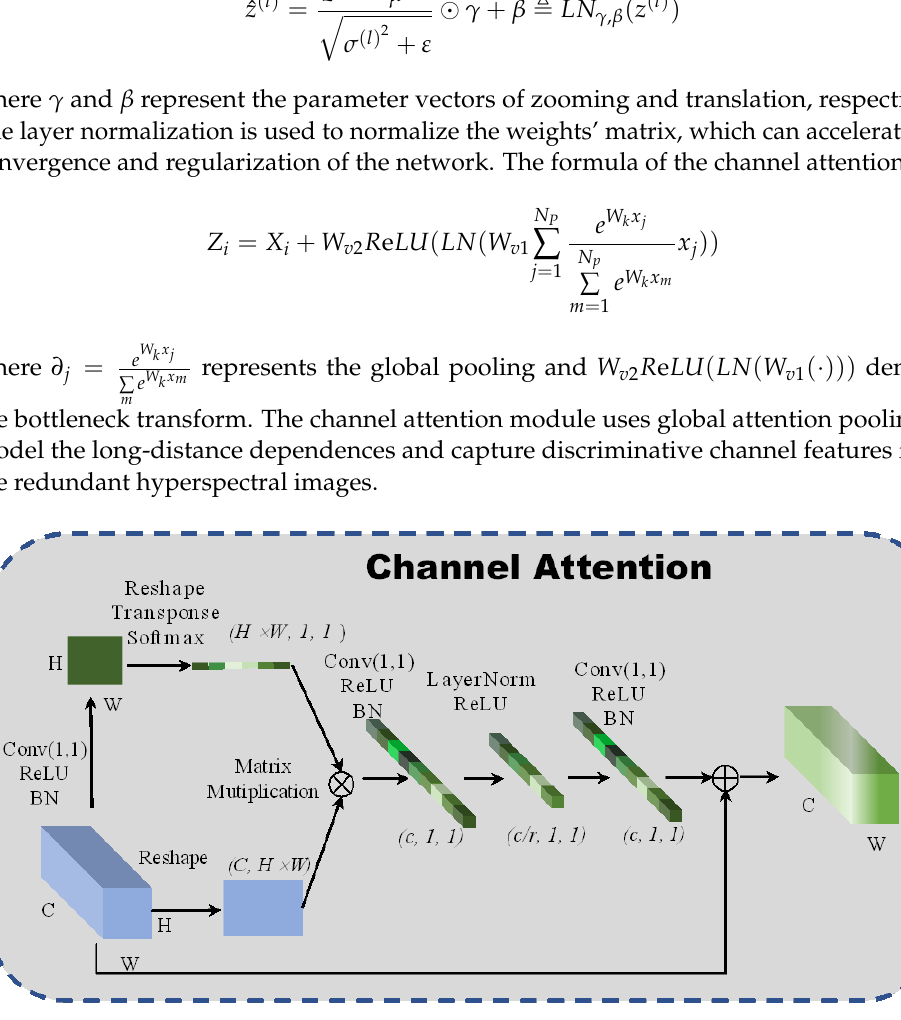
Figure 2. The architecture of 2D channel attention